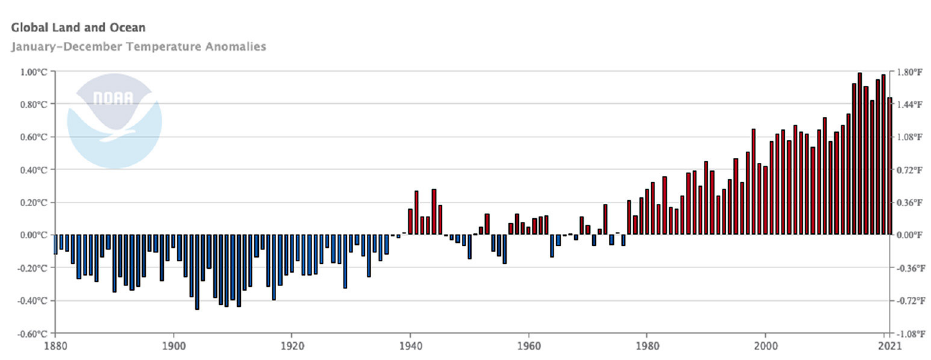
Fig. 2. – Annual and global mean surface temperature relative to the 20th century average as calculated by the US National Oceanic and Atmospheric Administration (NOAA). (Figure from NOAA